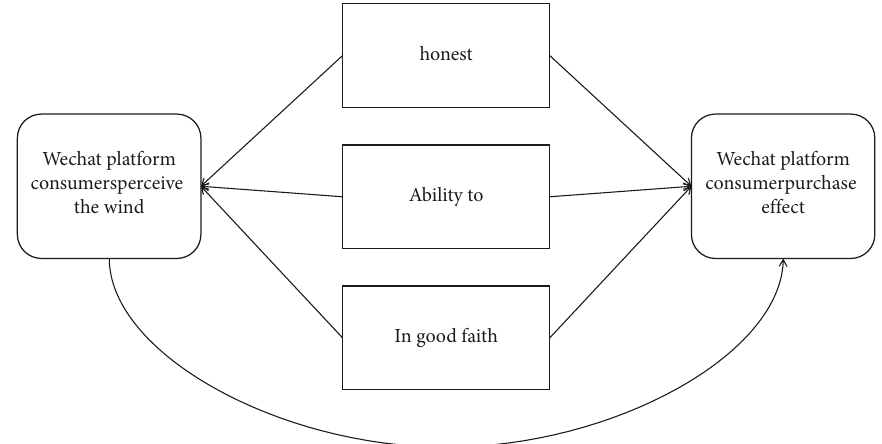
Figure 5: Purchase intention model on WeChat platform based on the trust dimension.